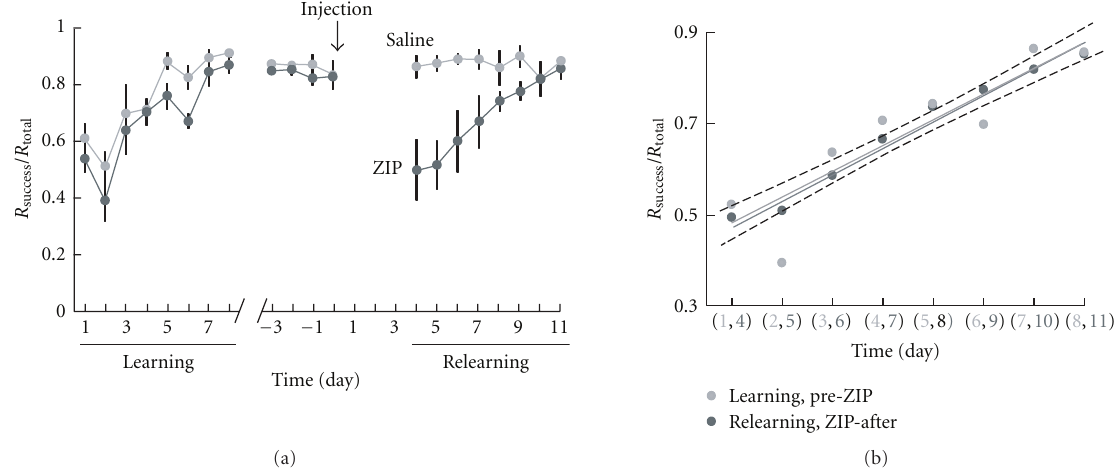
Figure 4: Figure and Figure legend taken and modified from [72] with permission. (a) shows the average percentage of successful reaches for both control and ZIP groups during initial learning and relearning after injection into the sensorimotor cortex. After reaching asymptotic levels of success, the animals were injected with either saline or ZIP. After 4 days rest, the animals were tested on the reaching task. Following the initial decline in performance to naive levels, the ZIP-injected rats relearned the task, and there was no significant di ff erence between the initial learning and the relearning curves of the ZIP-injected rats (b); ANCOVA P = 0 . 80, slope; P = 0 . 35, y intercept). This suggests that there were no significant memory savings or damage to the cortex due to the injections, as also indicated from the lack of change in the control animals’ performance after-injection. Histological analysis of brain sections indicates the spread of ZIP did not extend into subcortical regions, but encompasses several areas involved in skilled reaching including M1, M2, and S1 limb regions, see (Figure 3(b)) from